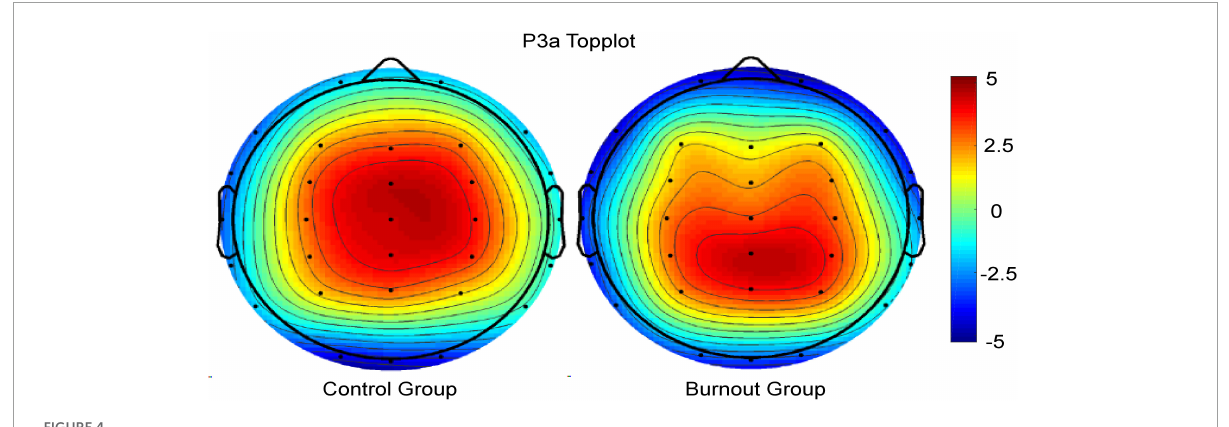
FIGURE4 Brain topographic map of P3a in the burnout group and the control group.